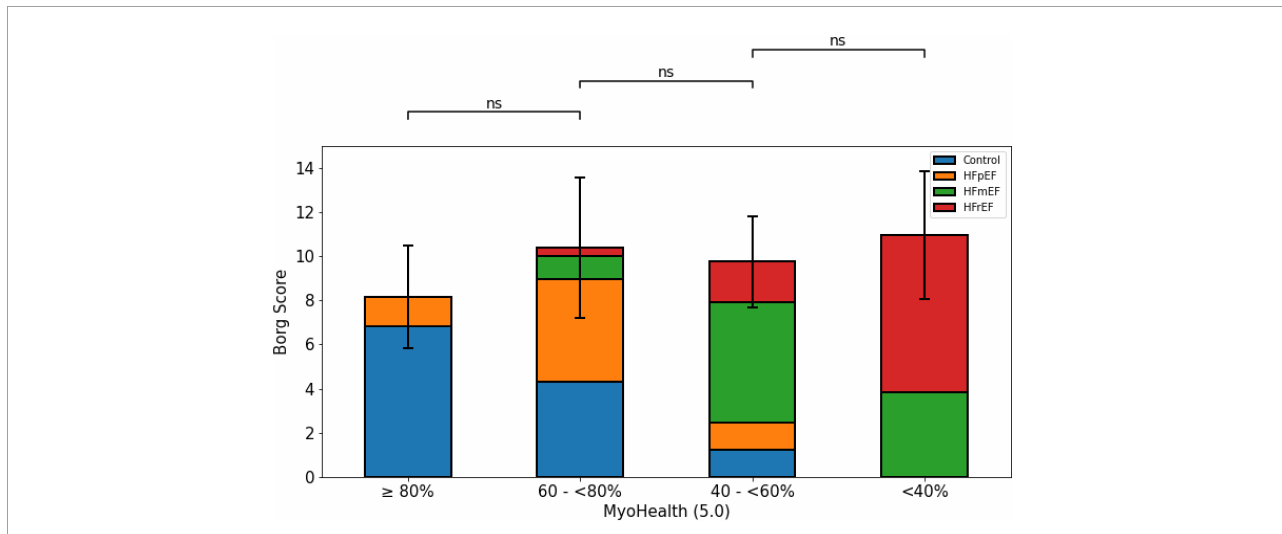
FIGURE2 Perceived exertion at the end of the 6-minute walk test across MyoHealth groups. MyoHealth ≥ 80% vs. MyoHealth 60– < 80%: p = 0.45; MyoHealth 60– < 80% vs. MyoHealth 40– < 60%: p = 1; MyoHealth 40– < 60% vs. MyoHealth < 40%: p = 0.43. ns, not